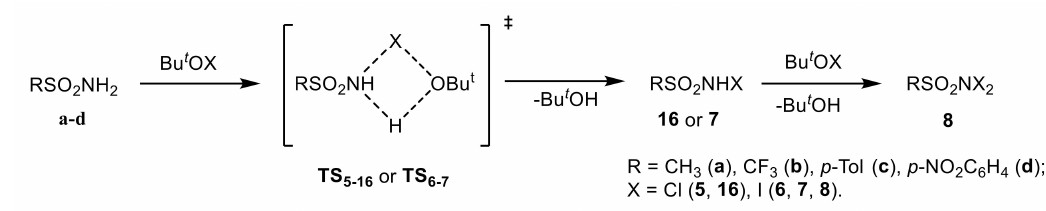
Table 2. Relative energies (kcal / mol) of π -complexes of divinylsilanes 3 , 4 with t -BuOCl 5 and t -BuOI 6 . Parameter 5 + 3 or 4 5 ··· 3 5 ··· 4 6 + 3 or 4 6 ··· 3 6 ··· 4 MP2 / DGDZVP // B3LYP / DGDZVP ∆ E + ZPVE 0.0